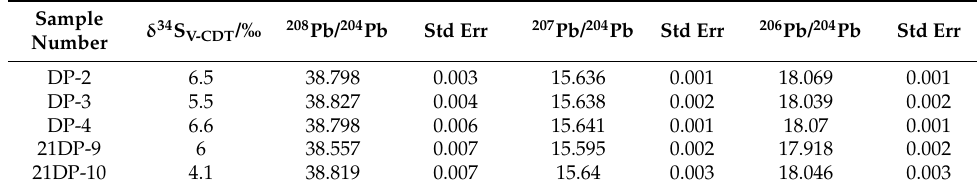
Table 4. Pyrite S–Pb isotopic data of the Dongpuzi gold deposit.